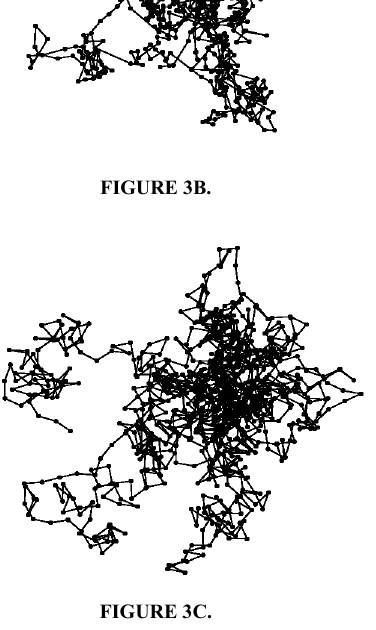
FIGURE 3. Based on data of Riecken and Ries[42] for the ground beetle Carabus coriaceus, a dispersal model was adapted[20,43]. To demonstrate the consequences of the movement specification for the distribution pattern, ten model individuals were started at the center of the area (representing 300 by 300 m) over a period of 90 days conforming to one annual activity period. (A) The standard model using the step range distribution of the observation; (B) 5% of the largest daily steps were eliminated from the available randomly chosen step sizes; (C) an average step size was used for each day instead of a spectrum of different step